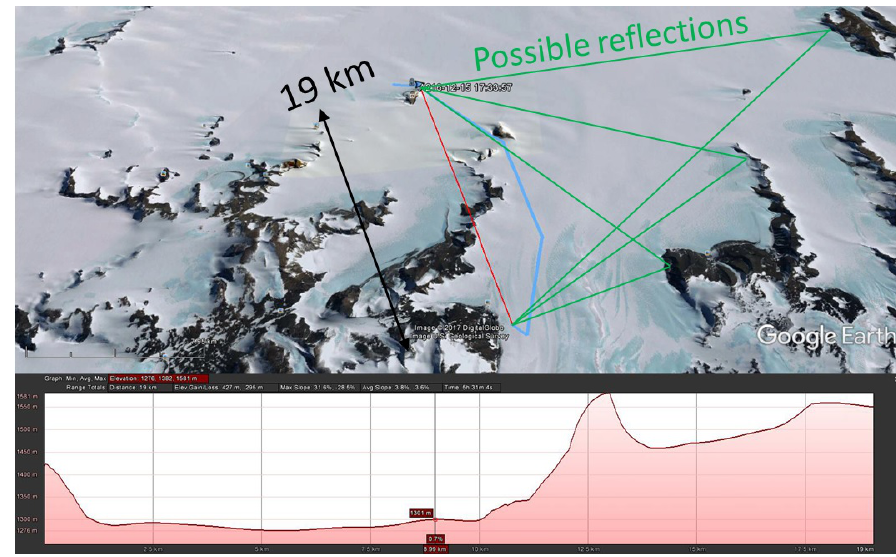
Figure 15. NLoS LoRa communication, with an indication of the potential propagation paths via reflection.